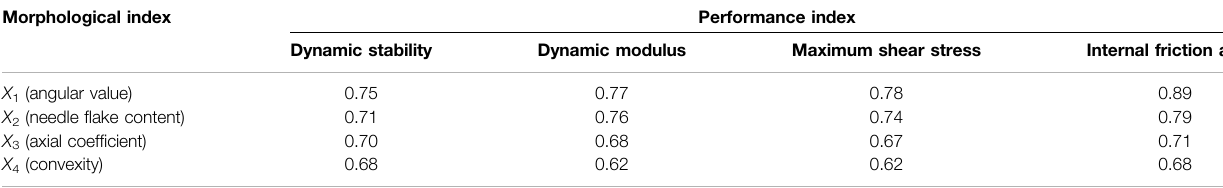
TABLE 5 | Correlation between morphological characteristics and high temperature performance index. Morphological index Performance index Dynamic stability